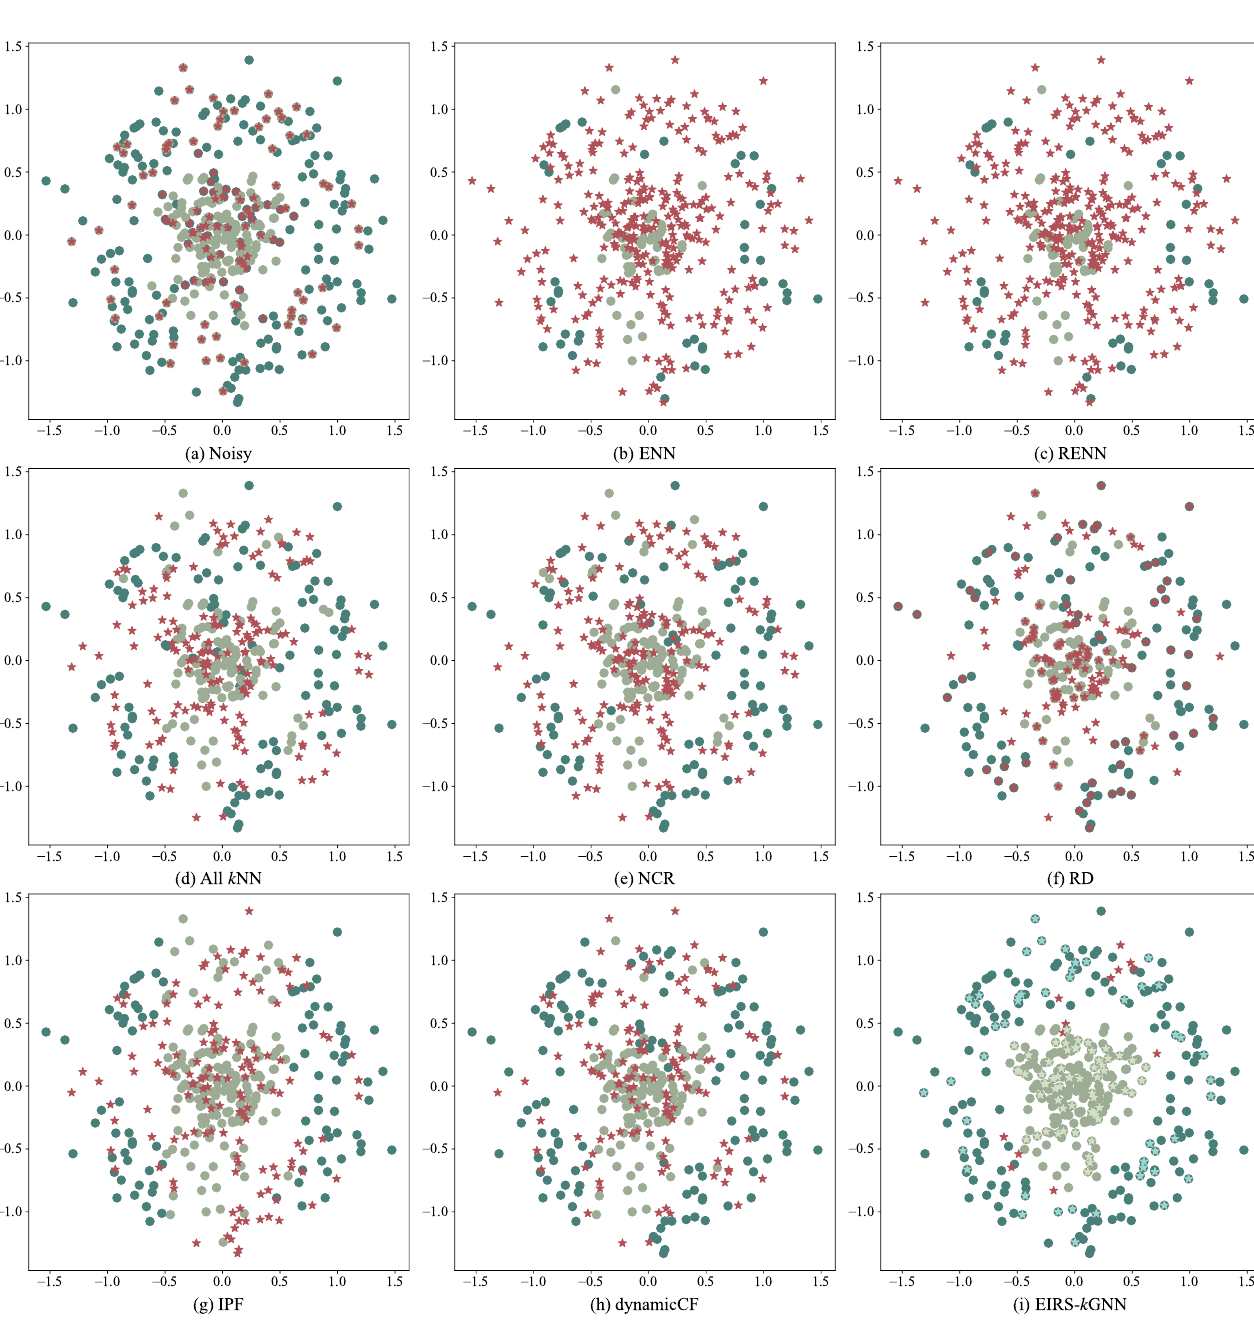
Figure 7. Different performances of various editing methods on the circles data